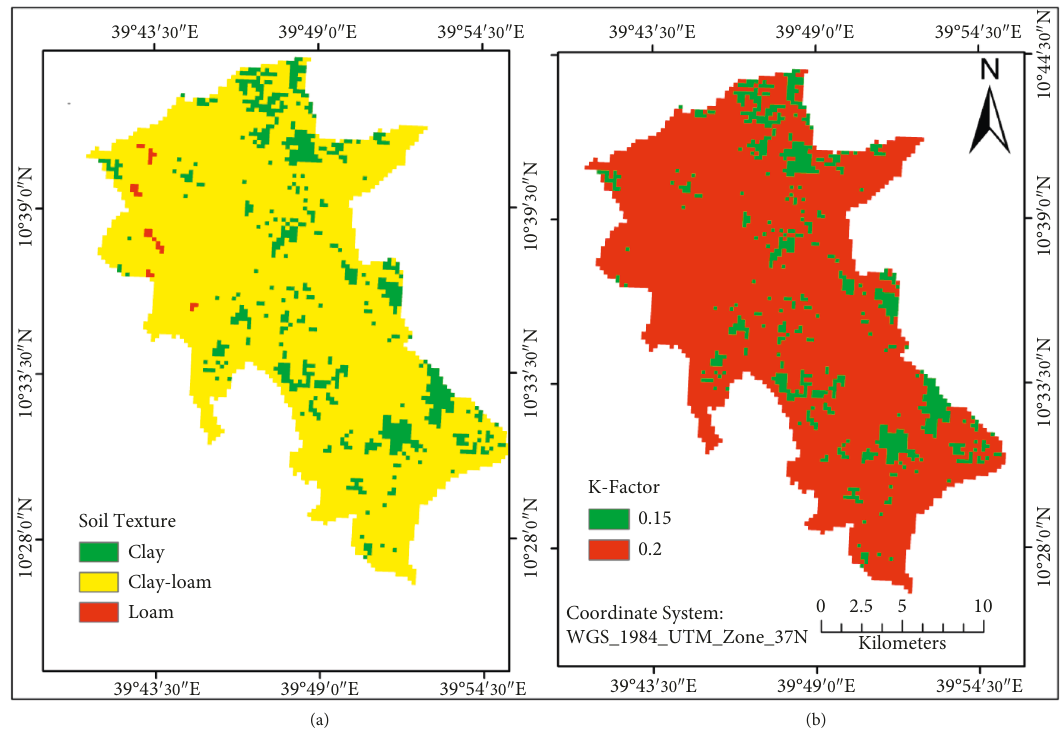
Figure 4: Map of (a) soil texture and (b) erodibility map (K-factor map) of the